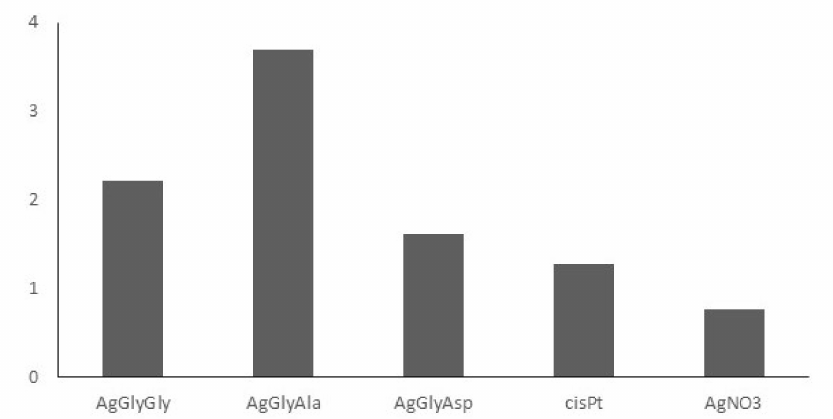
Figure 7. Selectivity index (SI) of Ag(I) dipeptide complexes for